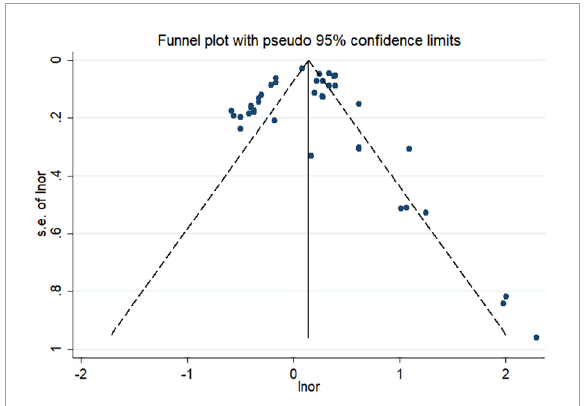
FIGURE9 Funnel plot of the association between IL-33/ST2 and coronary artery disease. s.e, standard error; lnor, logarithm of the odds